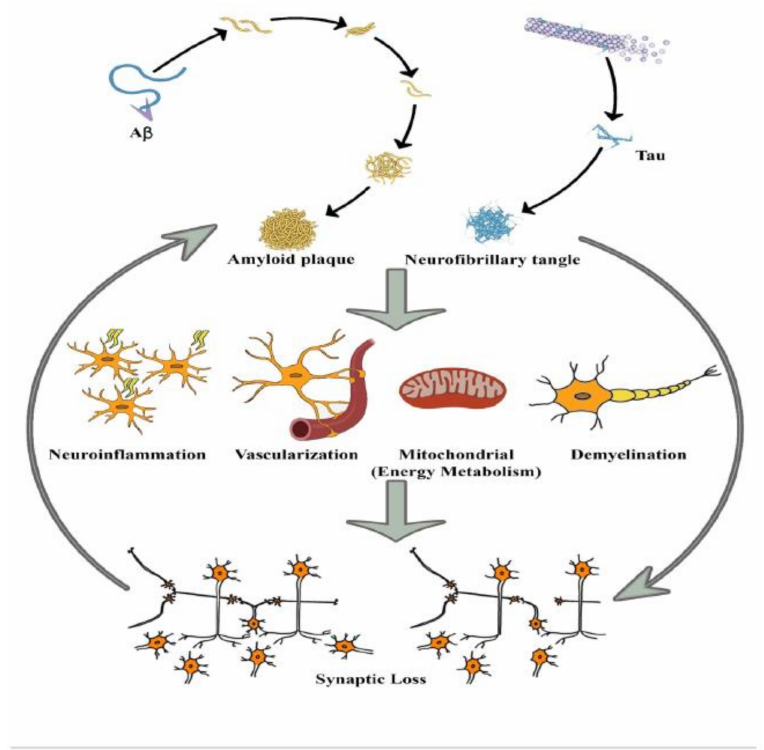
Figure 1. Systematic representation of the pathophysiology of Alzheimer’s